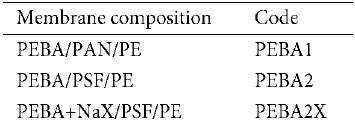
Table 1. Membranes composition and codes.